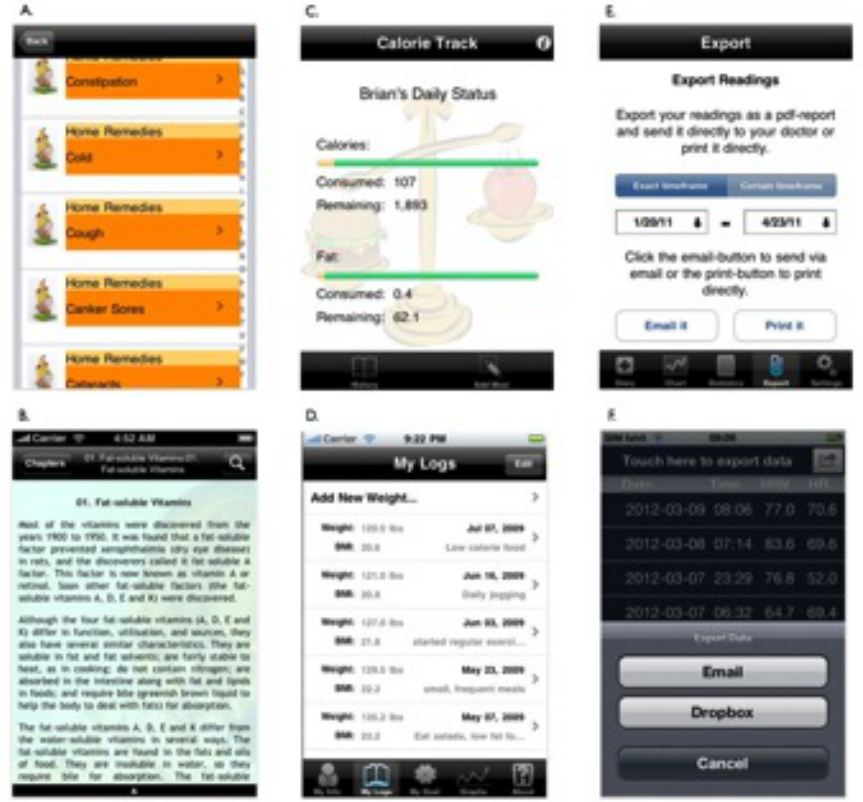
Figure 3. A. iHome Remedies (factor-predisposing); B. The Benefits of Vitamins (factor-predisposing); C. Calorie Track (factor-enabling); D. iWeight Track (factor-enabling); E. DiabetesPlus (factor-reinforcing); F. ithlete